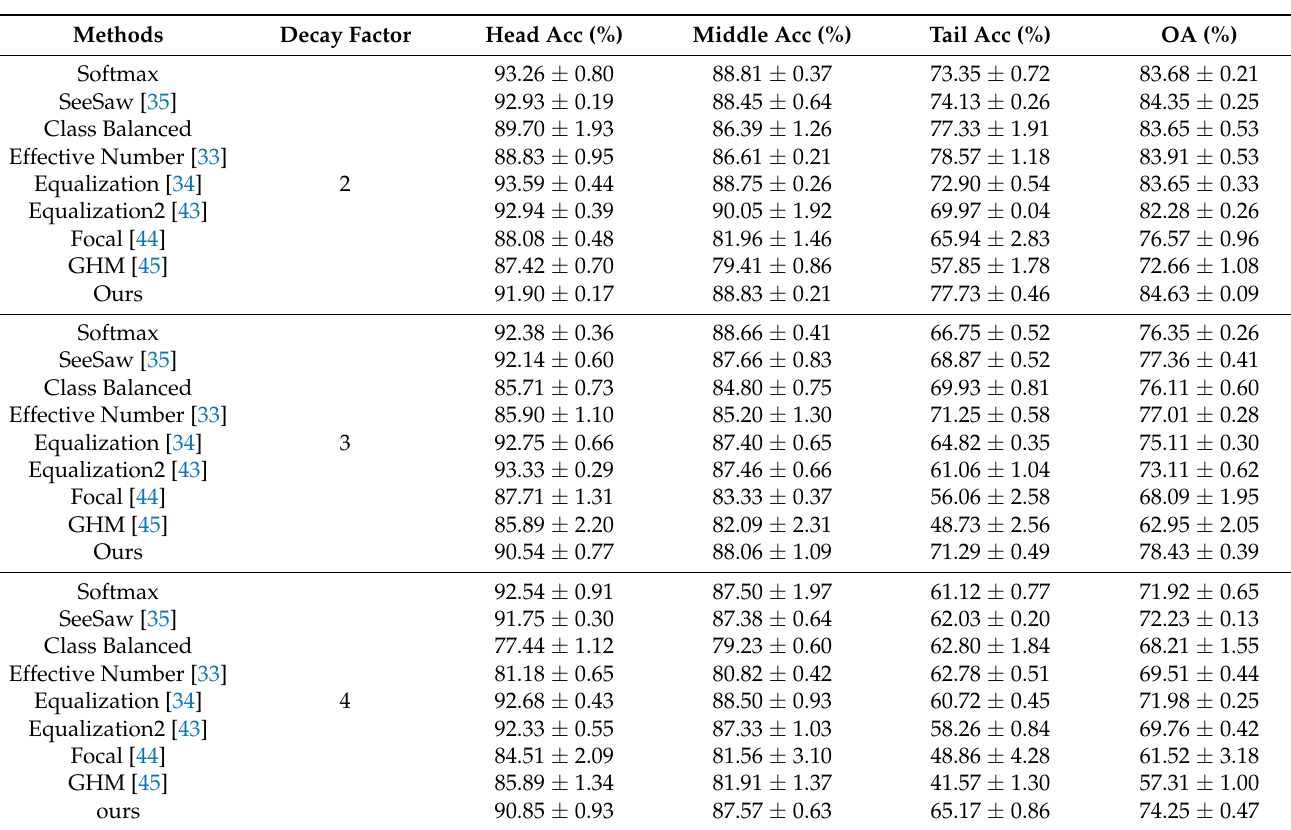
Table 6. Comparison results of the proposed method with other similar advanced methods on the long-tailed AID dataset with decay factors of 2, 3, and